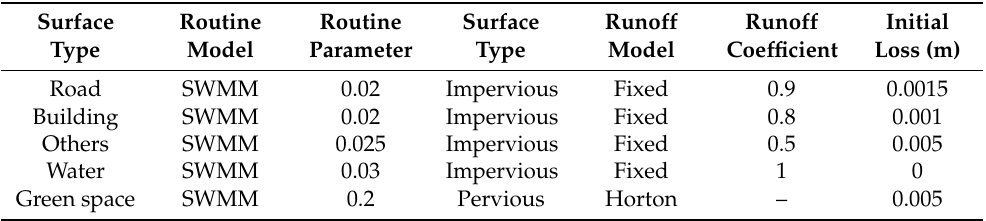
Table 2. Parameter attributes for five kinds of